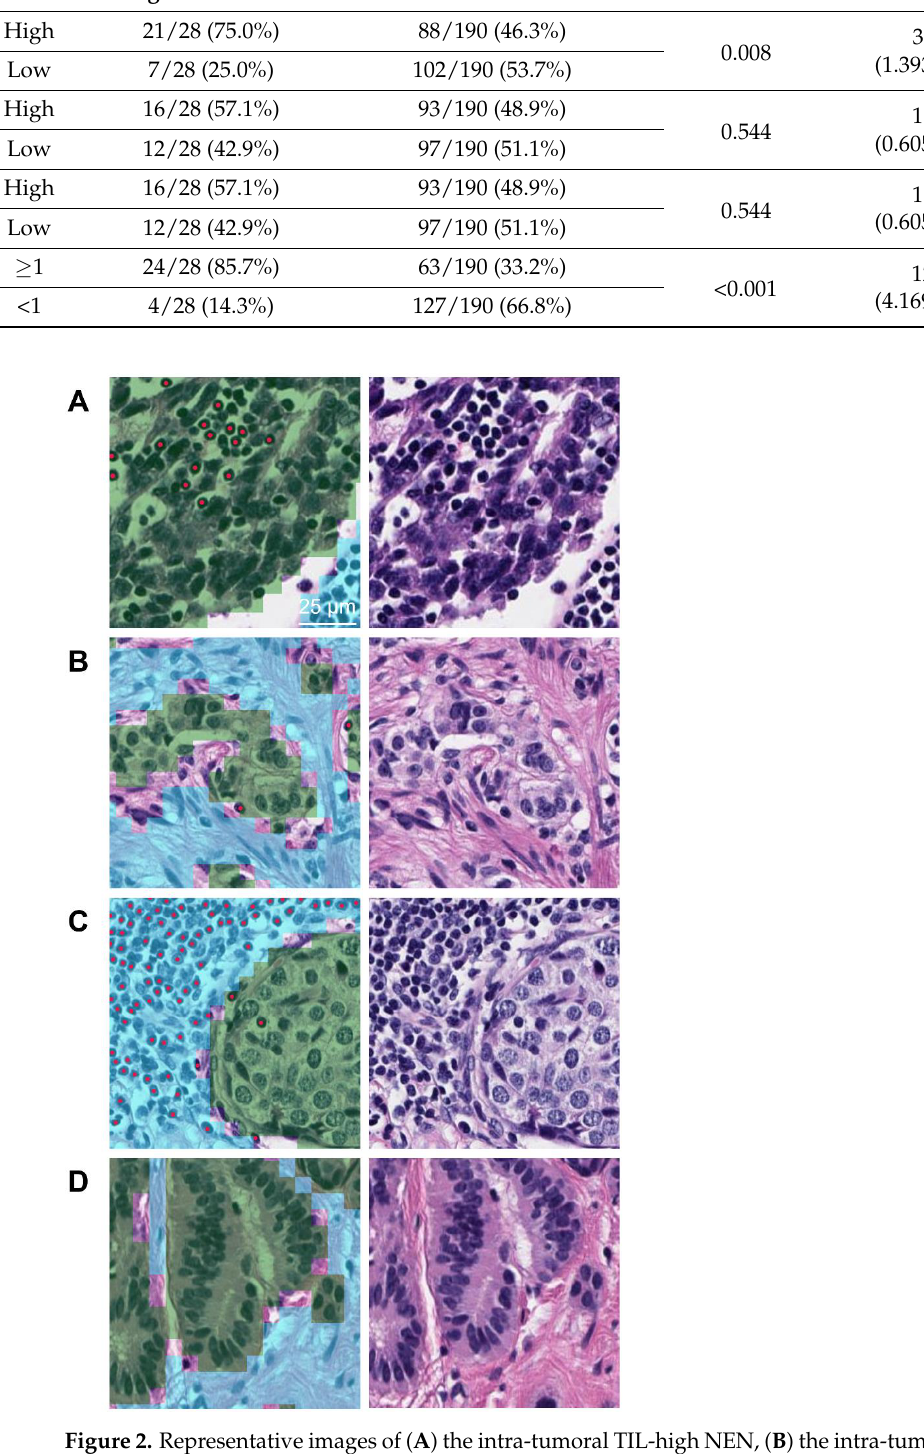
Figure 2. Representative images of ( A ) the intra-tumoral TIL-high NEN, ( B ) the intra-tumoral TIL-low NEN, ( C ) the stromal-TIL-high NEN, and ( D ) the stromal TIL-low NEN. Left image, H&E overlaid with AI-powered feature detection (green, tumor area; sky blue, tumor stroma; red dot, lymphocyte); right image, corresponding H&E image.